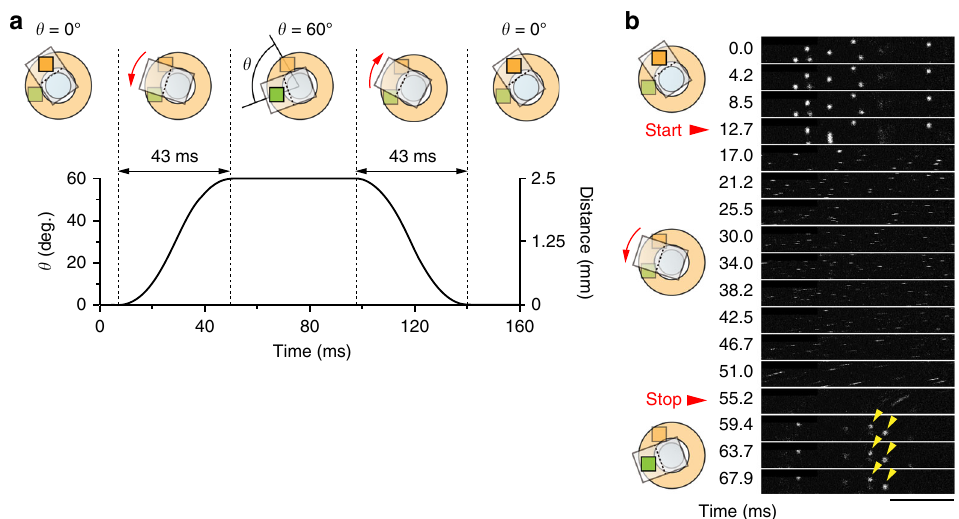
Fig. 3 Mechanical performance of the super-wide- fi eld TPLSM. a Representative time course of the rotation angle and the distance between the two FOVs. In this case, the FOV was moved from the orange fi eld to the green fi eld by rotating the device (represented by the rectangle) by 60°. The green fi eld was then imaged before the device was moved in the opposite direction to image the orange fi eld. Left, Y -axis, the true angle of the device ( θ ). Right, Y -axis, the distance between the centers of the two FOVs. b Time series of two-photon images of agarose-embedded fl uorescent microbeads (2 µ m) obtained by switching two FOVs at a distance of 2.5 mm. The frame rate was 236 frames s − 1 and the FOV was 57 × 512 pixels. Scale bar, 40 µ m